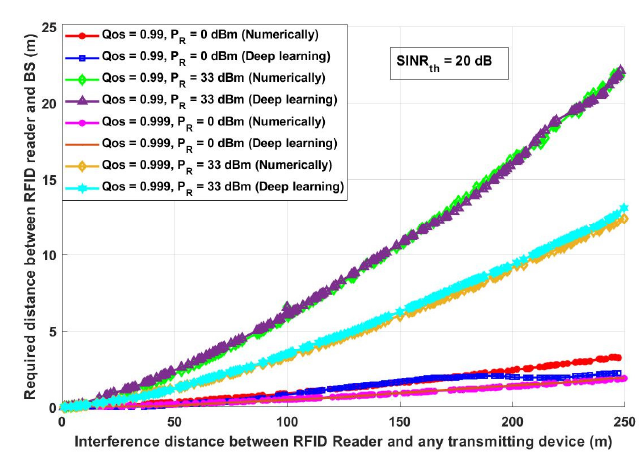
Figure 12. Interference Distance between an RFID reader and any transmitting devices (m) versus required distance between RFID and BS (m).